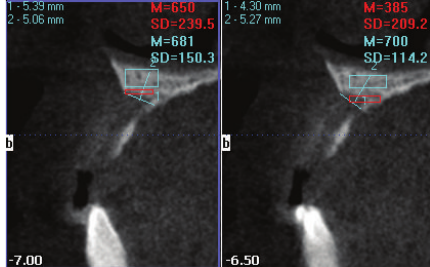
Figure 5: Transplanar images of of edentulous area on CBCT. Gross deficiency in dimensions of alveolar ridge is evident.